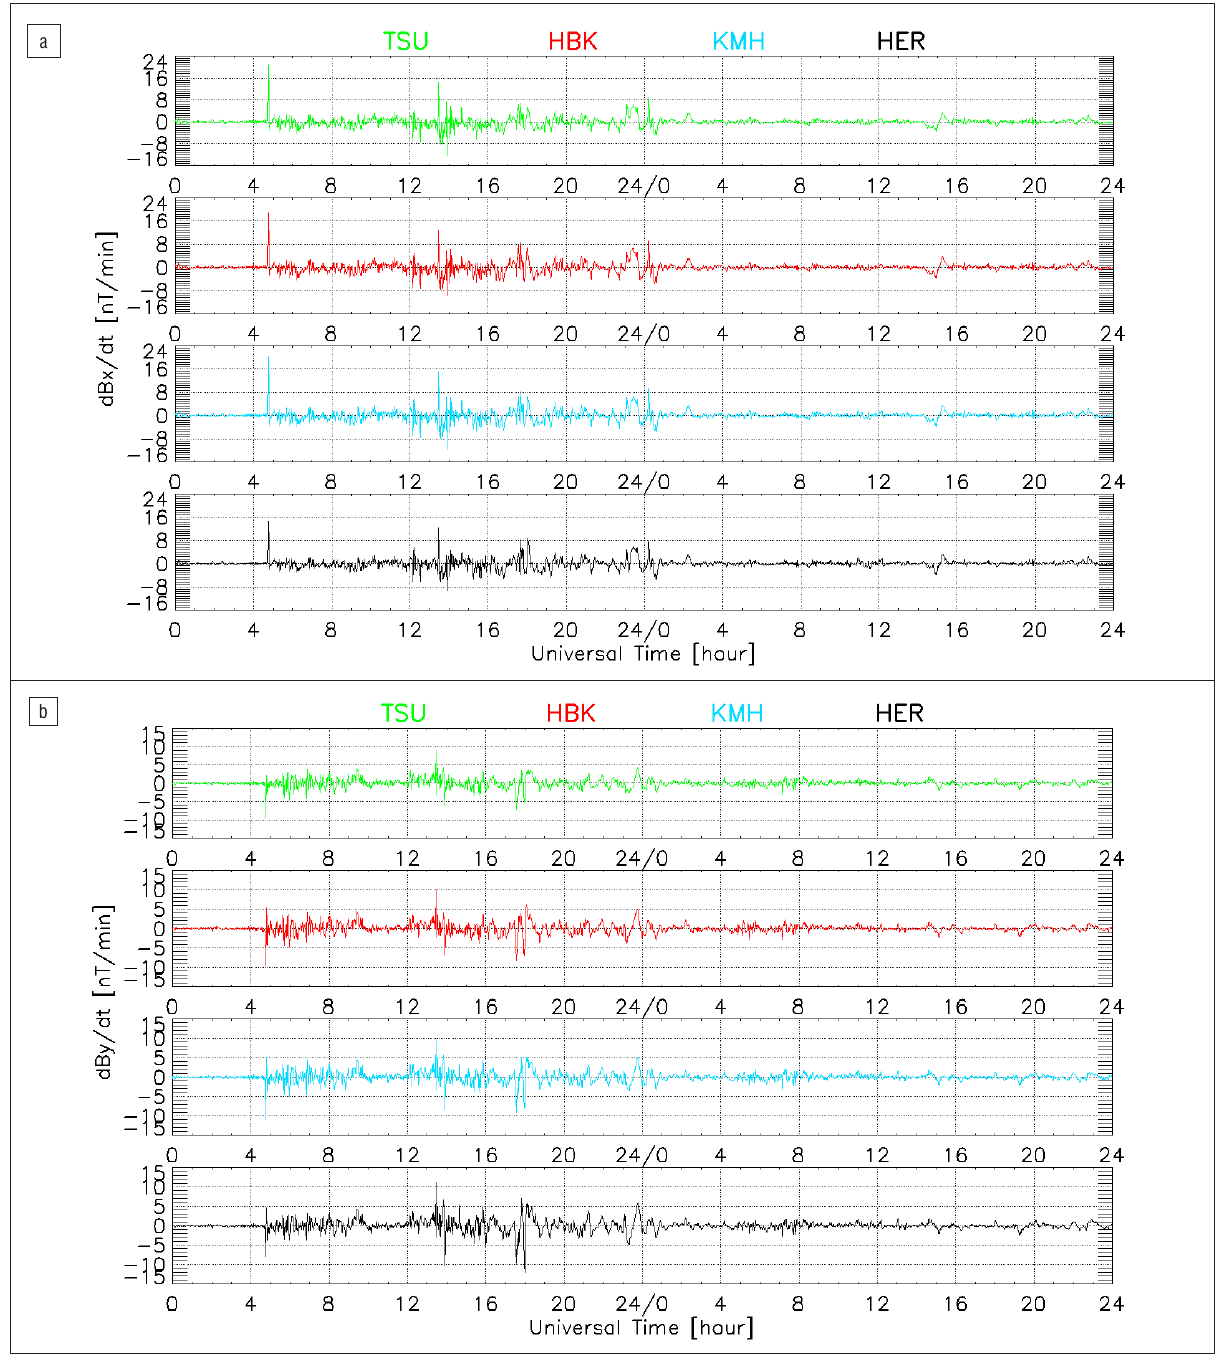
component (dB /dt) and (b) B component (dB /dt) derived from the measured data during the Saint x x y y